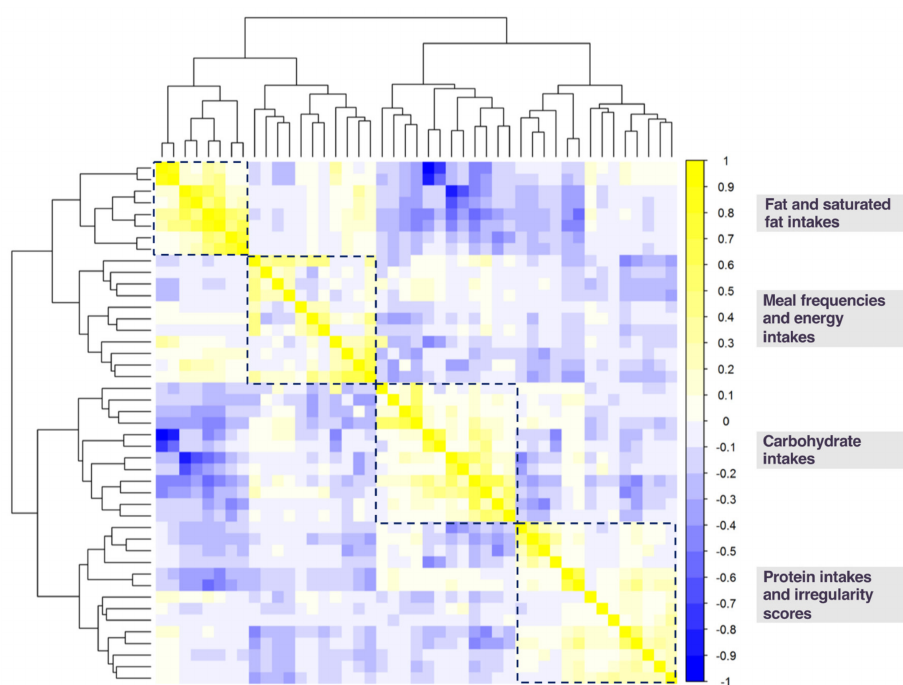
Figure 2. Dendrogram and correlation matrix of diet exposures. Variables are ordered by best fit to clusters determined by hierarchical clustering. The four-cluster solution is outlined in dashed lines. Yellow indicates a positive correlation coefficient; blue indicates a negative correlation coefficient. Variable order from top to bottom and left to right: (1) average fat for breakfast; (2) average saturated fat for breakfast; (3) average fat for lunch; (4) average saturated fat for lunch; (5) average daily fat intake; (6) average daily saturated fat intake; (7) average fat for dinner; (8) average saturated fat for dinner; (9) average daily eating occasions; (10) dinner frequency; (11) breakfast frequency; (12) lunch frequency; (13) late night and early morning snack frequency; (14) average calories for snacks; (15) evening snack frequency; (16) average calories for breakfast; (17) average calories for dinner; (18) average calories for lunch; (19) average daily caloric intake; (20) average fiber for breakfast; (21) average fiber for dinner; (22) average fiber for lunch; (23) average daily fiber intake; (24) average carbohydrates for breakfast; (25) average sugar for breakfast; (26) average carbohydrates for lunch; (27) average sugar for lunch; (28) average daily carbohydrate intake; (29) average daily sugar intake; (30) average carbohydrates for dinner; (31) average sugar for dinner; (32) average protein for lunch; (33) average daily protein intake; (34) average protein for dinner; (35) average protein for breakfast; (36) saturated fat irregularity; (37) fat irregularity; (38) breakfast irregularity; (39) lunch irregularity; (40) dinner irregularity; (41) sugar irregularity; (42) carbohydrate irregularity; (43) protein irregularity; (44) fiber irregularity; (45) daily caloric